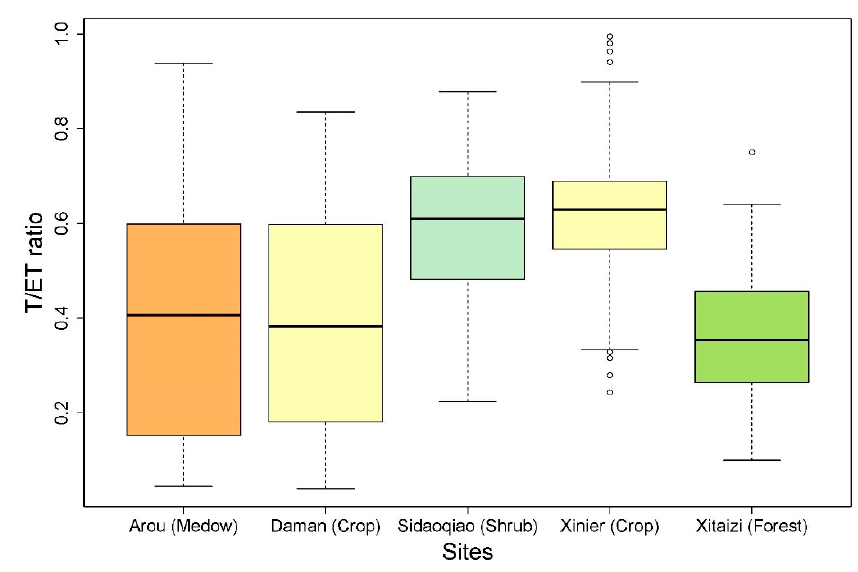
Figure 8. Frequency distribution of weekly T/ET ratio.